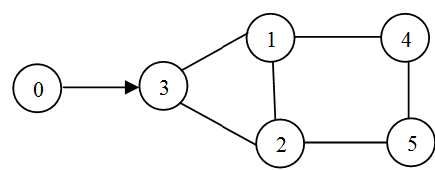
Figure 1. Communication